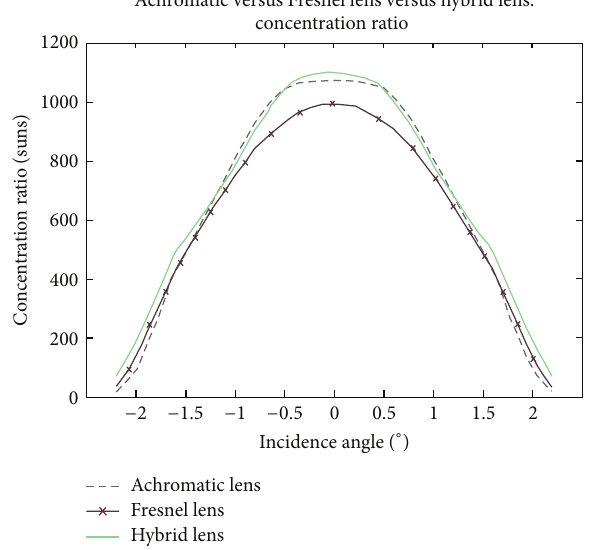
Figure 13: Concentration ratio versus incidence angle. Hybrid, achromatic, and Fresnel